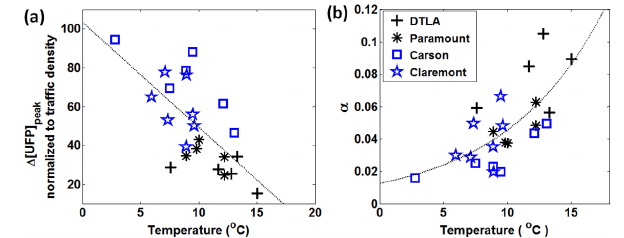
Figure 7. Temperature effects on (a) peak concentration difference from the background ( 1 [UFP] peak = [UFP] peak − background [UFP] bkgnd ) normalized to traffic density and (b) disper- sion coefficient α . Black dotted lines are curve fits: (a) 1 [UFP] peak · (Traffic) − 1 =− 5.41 · T + 103.4 ( R 2 = 0.46)